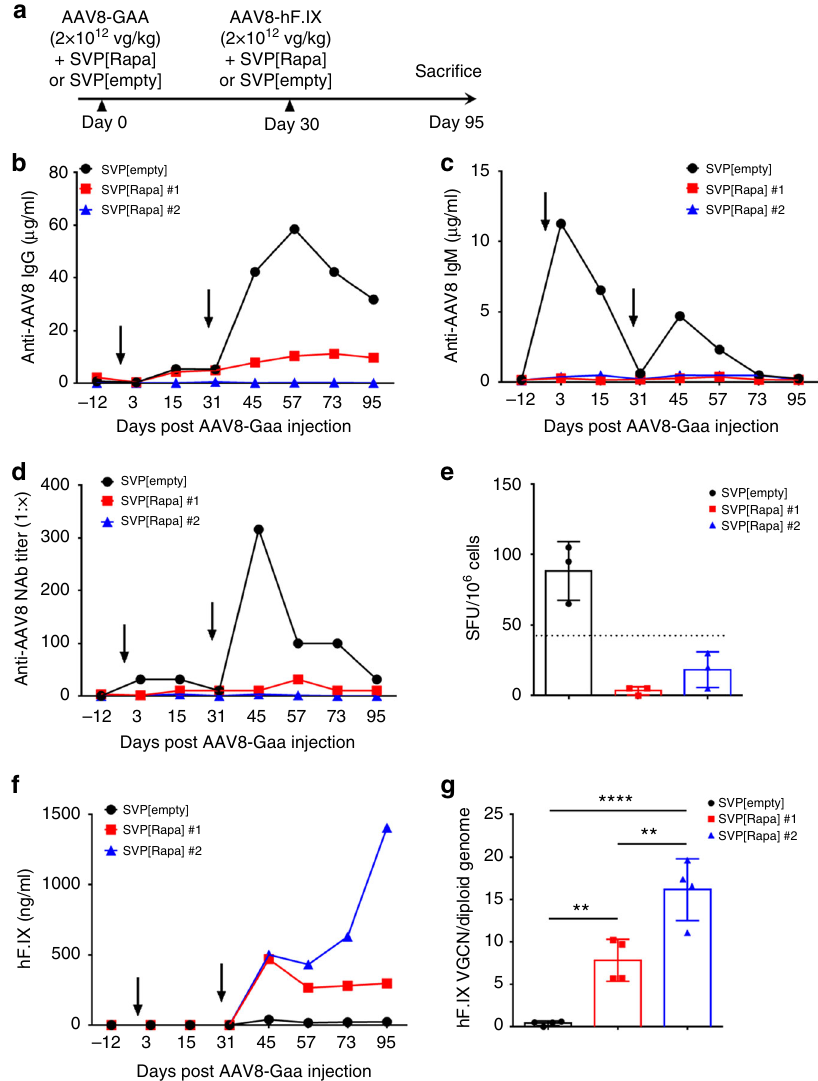
Fig. 2 SVP[Rapa] treatment enables AAV8 re-administration in nonhuman primates. a Protocol outline. Male naive cynomolgus monkeys were treated i.v. with 2 × 10 12 vg kg − 1 of AAV8-Gaa vector and either SVP[Rapa] (3 mg kg − 1 , n = 2, SVP[Rapa]#1 and SVP[Rapa]#2) or SVP[empty] control ( n = 1) and then challenged i.v. on day 30 with 2 × 10 12 vg kg − 1 of AAV8-hF.IX vector and either SVP[Rapa] or SVP[empty] control, as described above. b , c Analysis of b anti-AAV8 IgG antibodies and c anti-AAV8 IgM antibody responses measured by ELISA. d Analysis of anti-AAV8 neutralizing antibodies (NAb) measured with a cell-based neutralization assay. e Analysis of anti-AAV8 IgG secreting B cells in splenocytes measured by B ELISpot. Data are shown as individual replicates and the bars represent mean ± s.d. The dotted line indicates the threshold for positivity corresponding to 50 spot forming units (SFU) per million cells. f Plasma hF.IX antigen levels quanti fi ed by ELISA at the indicated time points following administration of AAV8-hF.IX vector. g AAV8-hF. IX vector genome copy number (VGCN) per diploid genome in liver. The symbols represent individual liver lobes (left, right, caudate and quadrate) and the bars represent the mean ± s.d. (4 liver lobes per monkey; one-way ANOVA with Tukey post hoc test, ** p < 0.01, **** p < 0.0001) The arrows represent the timing of each AAV8 vector